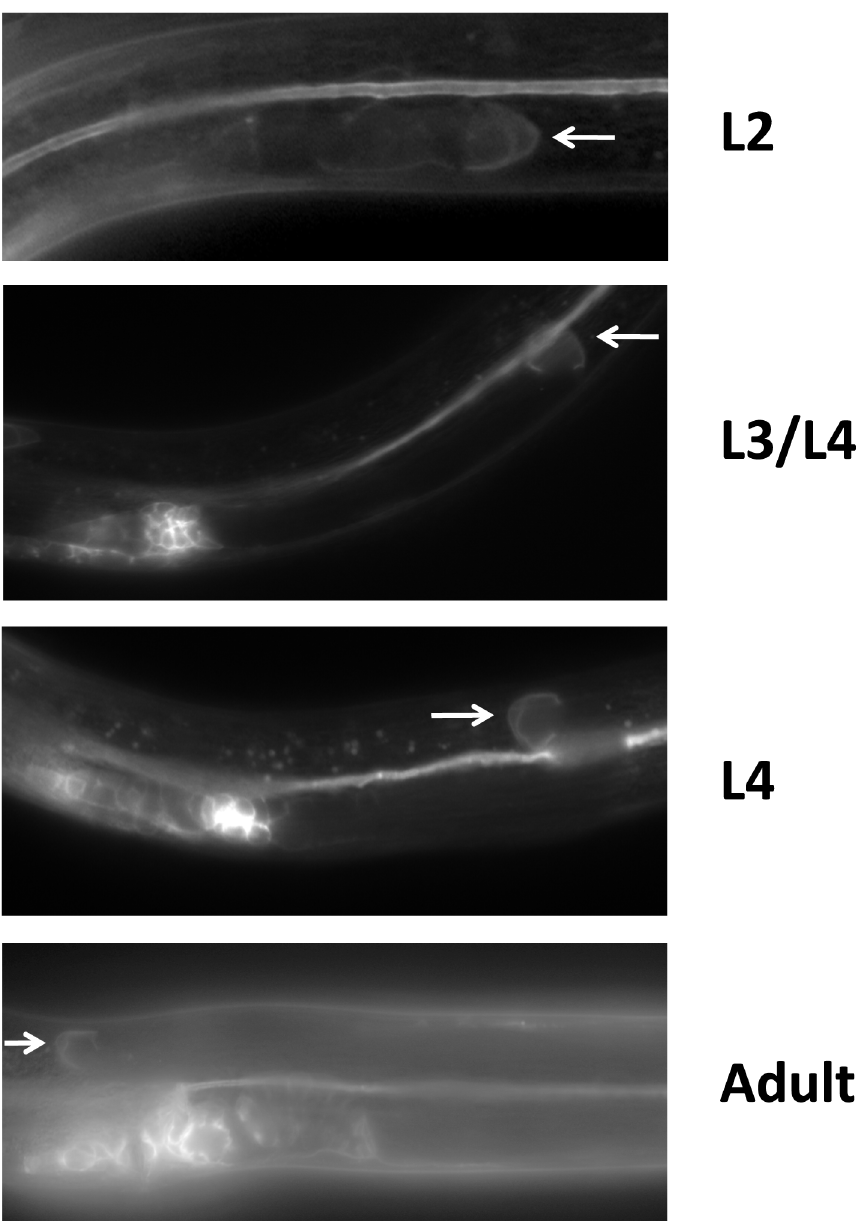
Figure 4. LIN-17 is expressed in the hermaphrodite DTCs throughout development. Fluorescence micrographs of KS411 hermaphrodites bearing lin-17::gfp [58]. Dorsal is up and anterior is left. Arrows mark the DTC. Developmental stage is indicated on the right. L2–L4 represent the three larval stages preceding the adult stage.